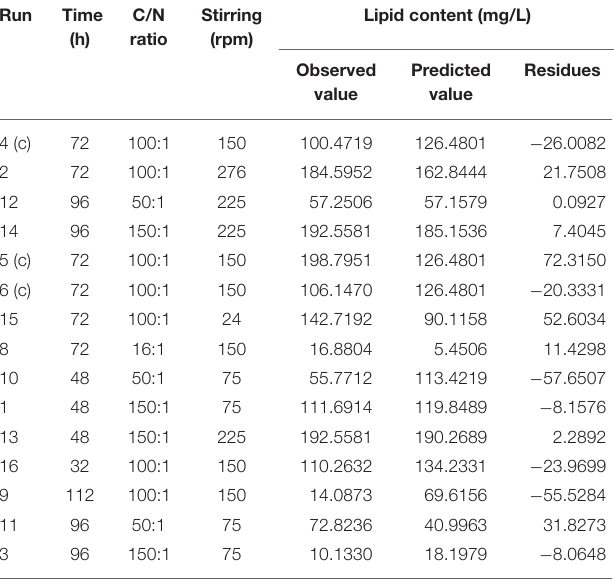
TABLE 4 | Analysis of variance for the fitted quadratic polynomial model for optimization of cellular lipid production ( P < 0.05). Factor SS